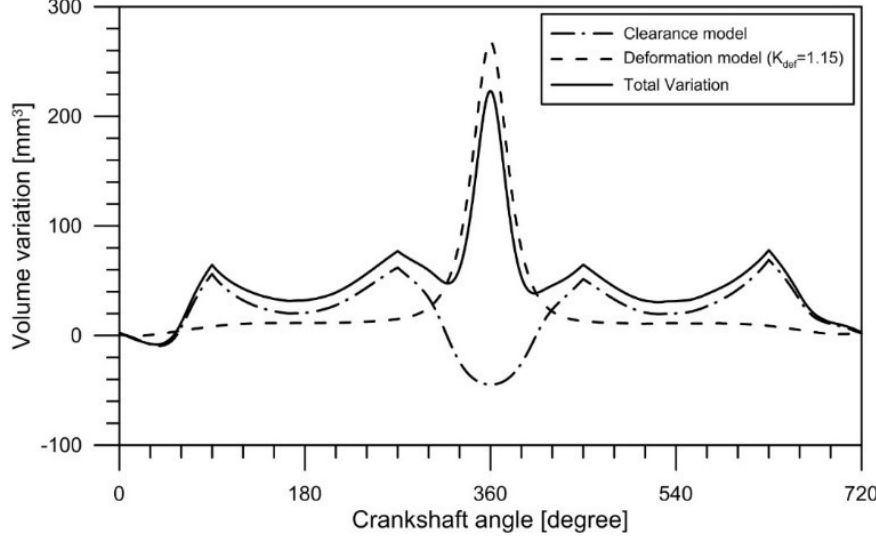
Figure 14. Variation of volume by clearance and adjusted model, for 1500 rpm.